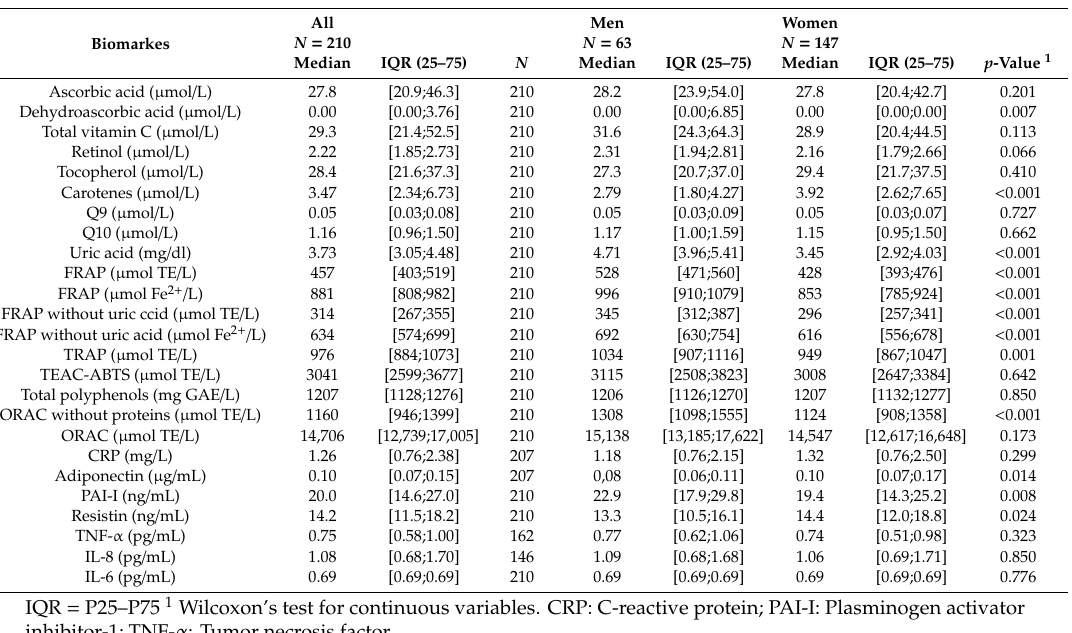
Table 2. Plasma biomarker levels in the study sample (63 males and 147 females) within the EPIC Granada–Gipuzkoa study.